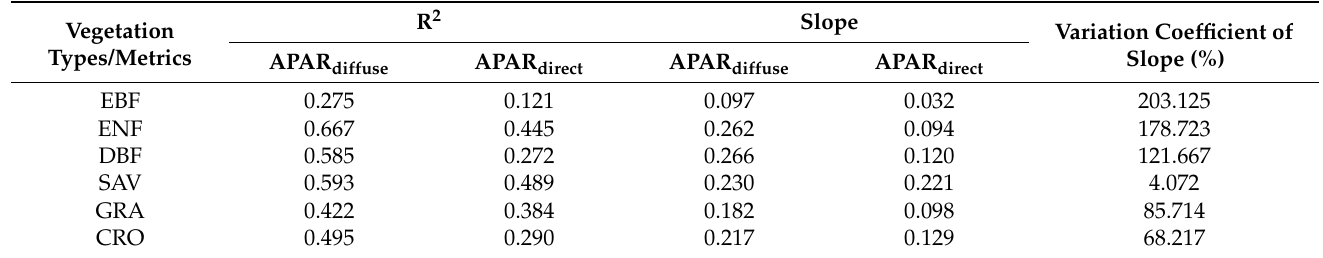
Table 5. The statistical metrics of the diffuse (left side) and direct APAR (right side) towards GPP.